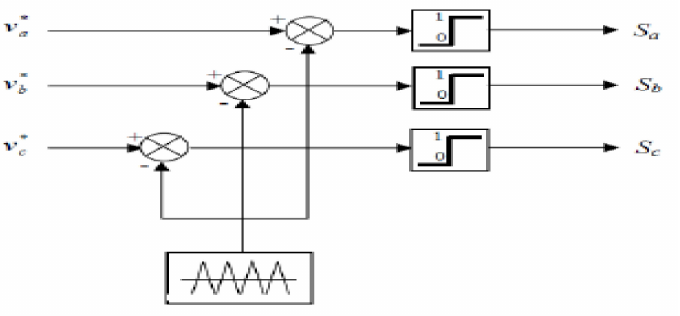
Figure 5. The control of the Inverter switch.